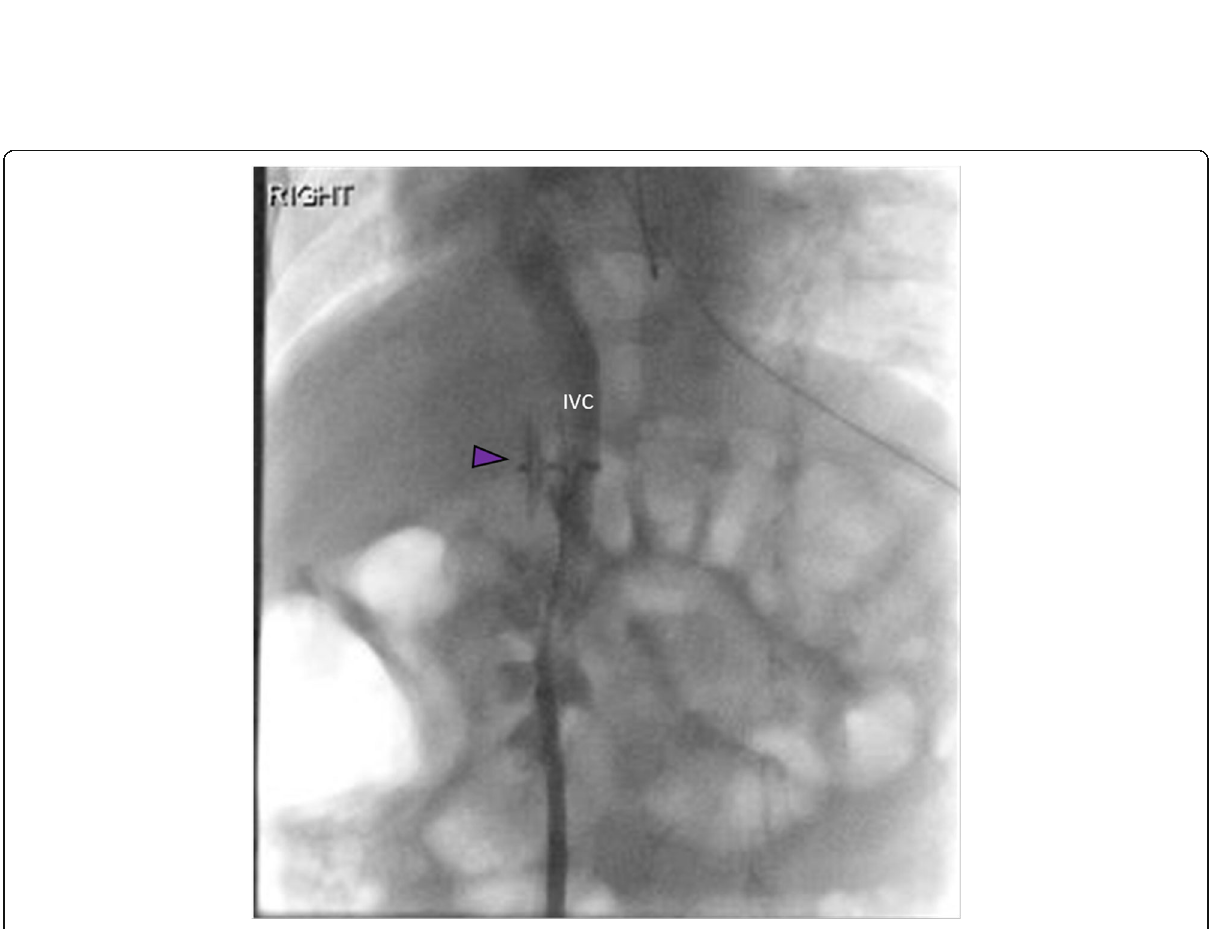
Fig. 3 Occlusion of CPSS with Amplatzer PFO OD: Fluoroscopic placement of an Amplatzer PFO OD into the CPSS (purple arrowhead). Unidirectional flow of contrast is seen through the IVC (labeled) with absence of flow through the PV